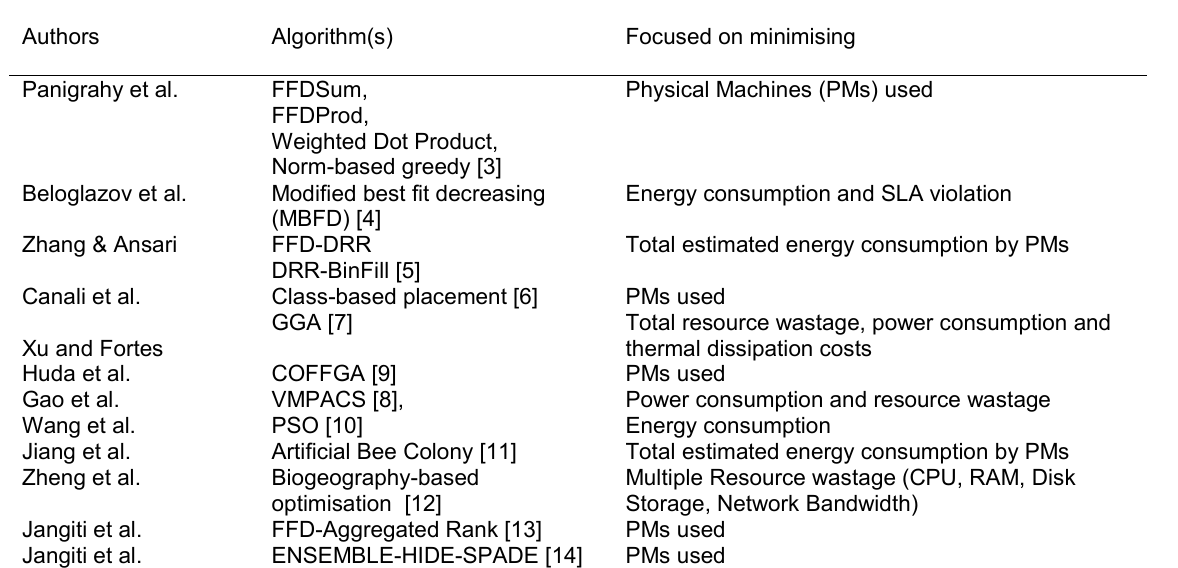
Table 1. State of the art review of VM placement approaches.